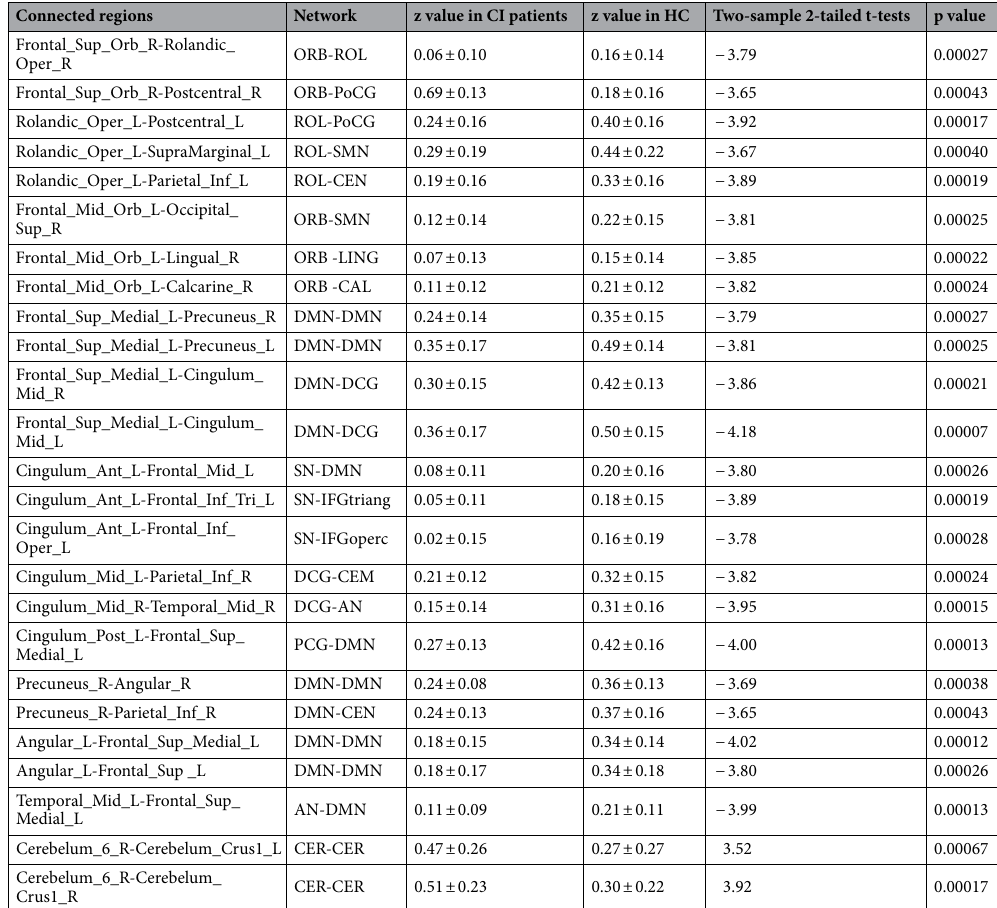
Table 3. Decreased and increased functional connectivities in CI patients (multiple comparison correction— GRF, p-voxel < 0.001, p-cluster < 0.05). CI chronic insomnia, HC healthy control, L left, R right, DMN default mode network, SN salience network, AN affective network, CEN central-executive network, SMN sensory- motor network, CER cerebellum, Frontal_Sup_Orb (ORB) superior frontal gyrus orbital part, Frontal_Mid middle frontal gyrus, Frontal_Inf_Tri (IFGtriang) inferior frontal gyrus, triangular part, Frontal_Inf_Oper_L (IFGoperc) inferior frontal gyrus, opercular part, Rolandic_Oper (ROL) rolandic operculum, Frontal_Sup_ Medial medial superior frontal gyrus, Frontal_Mid_Orb (ORB) middle frontal gyrus orbital part, Cingulum_ Ant anterior cingulate paracingulate gyrus, Cingulum_Mid (DCG) median cingulate paracingulate gyrus, Cingulum_Post posterior (PCG), cingulate gyrus, Calcarine (CAL) calcarine fissure and surrounding cortex, Lingual (LING) lingual gyrus, Occipital_Sup superior occipital lobe, Postcentral (PoCG) postcentral gyrus, Parietal_Inf Inferior parietal gyrus, Supra Marginal supramarginal gyrus, Angular angular gyrus, Precuneu s precuneus, Temporal_Mid middle temporal gyrus, Cerebelum_6 Cerebellum_Superior, Cerebelum_Crus1 part of cerebellum.